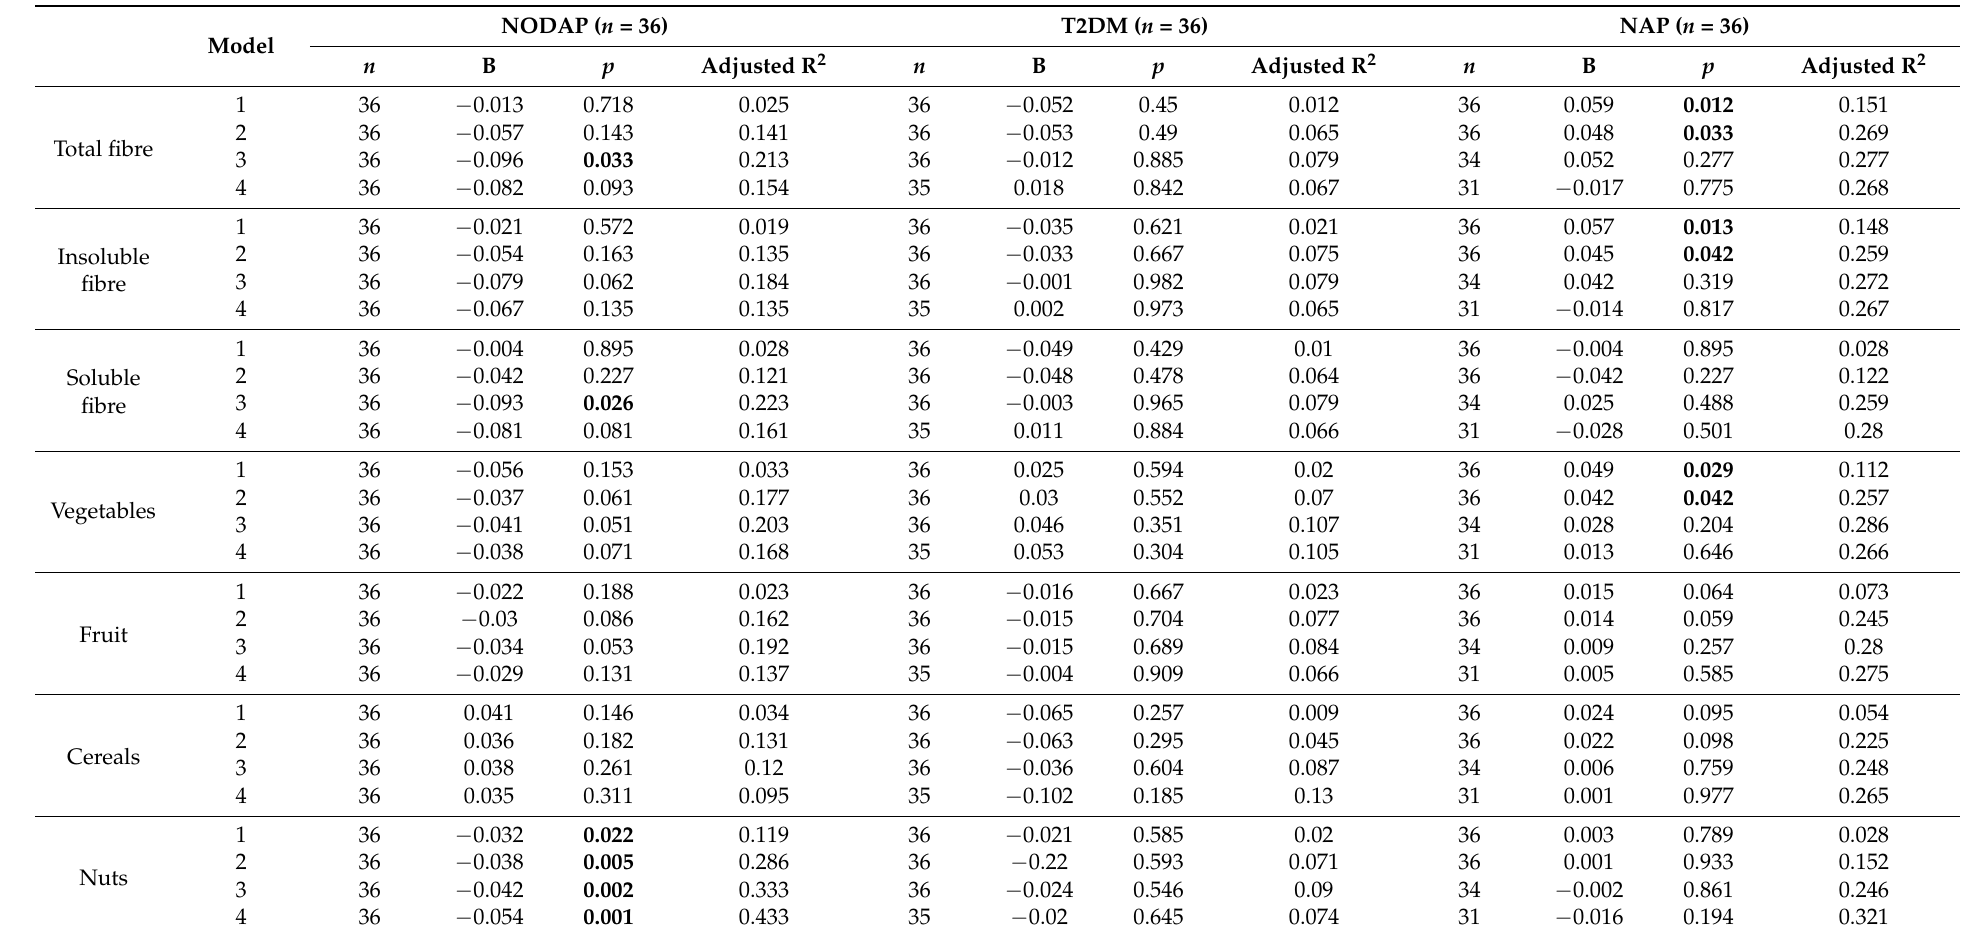
Table 3. Associations between dietary fibre intake and glycated